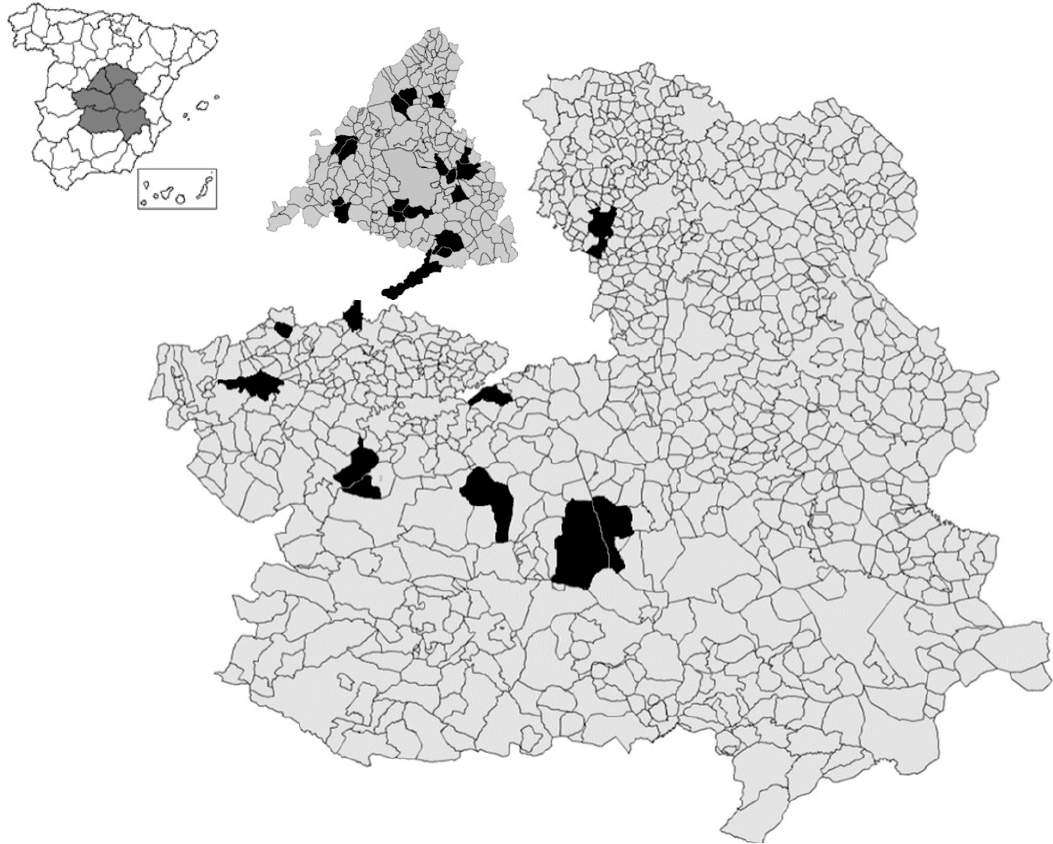
Figure 1. Communities included in the database and location in central